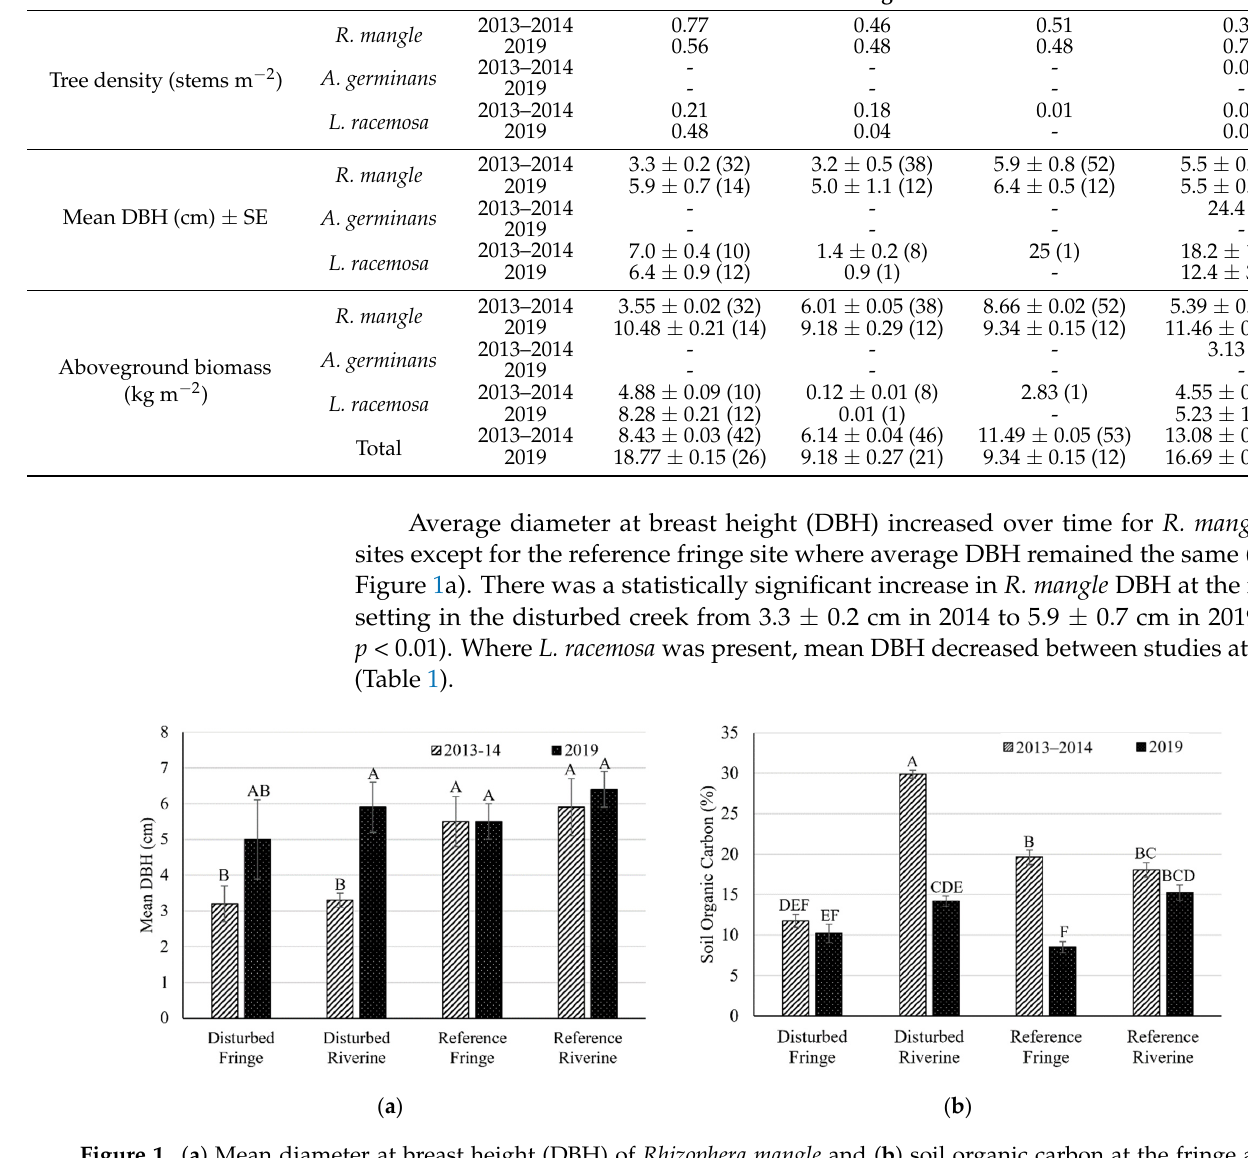
est biomass was the disturbed creek riverine site with 18.77 ± 0.15 kg m − 2 which increased